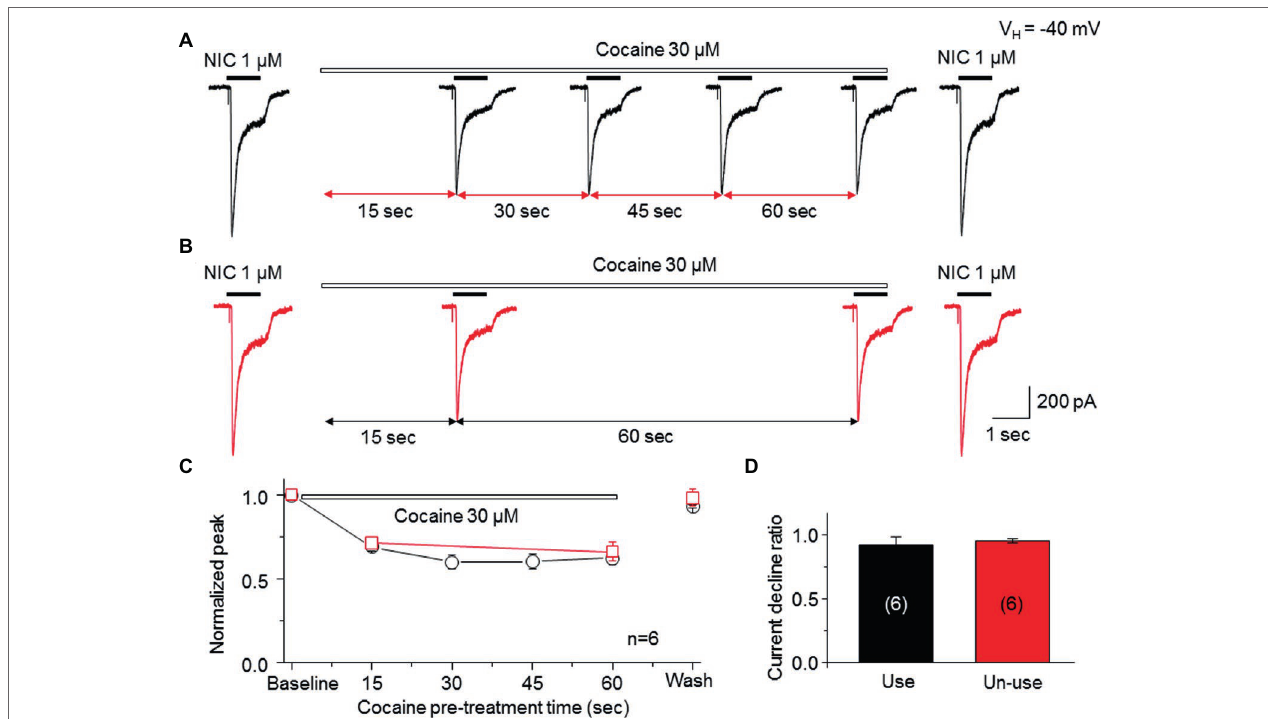
FIGURE 5 | Cocaine inhibits an α 6*-nAChR-mediated current in a nonuse-dependent manner. (A) NIC use protocol includes repetitive applications of NIC four times with 15-s interval in the presence of cocaine. (B) NIC nonuse protocol includes repetitive applications of NIC two times with 60-s interval in the presence of cocaine. (C) Time-dependent decline of NIC current with four applications (black) and with two applications (red) in the presence of cocaine. (D) Comparison of the current declined ratio between the “use” (4th NIC response/1st NIC response, n = 6) and the “nonuse” (2nd NIC response/1st NIC response, n = 6) protocols showed no significant